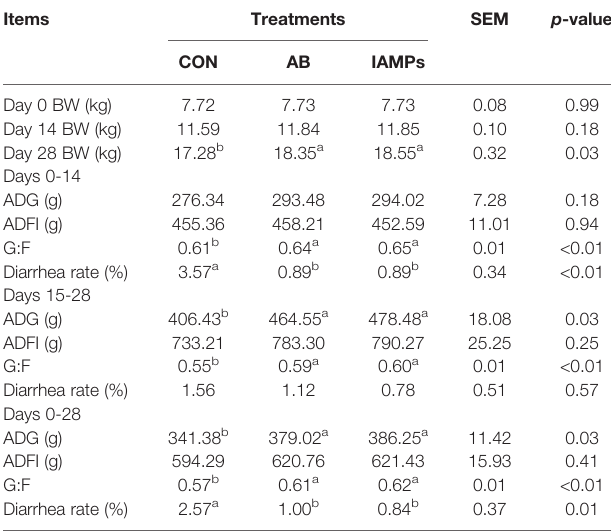
TABLE 3 | Effects of IAMPs on growth performance and diarrhea rate of weaning